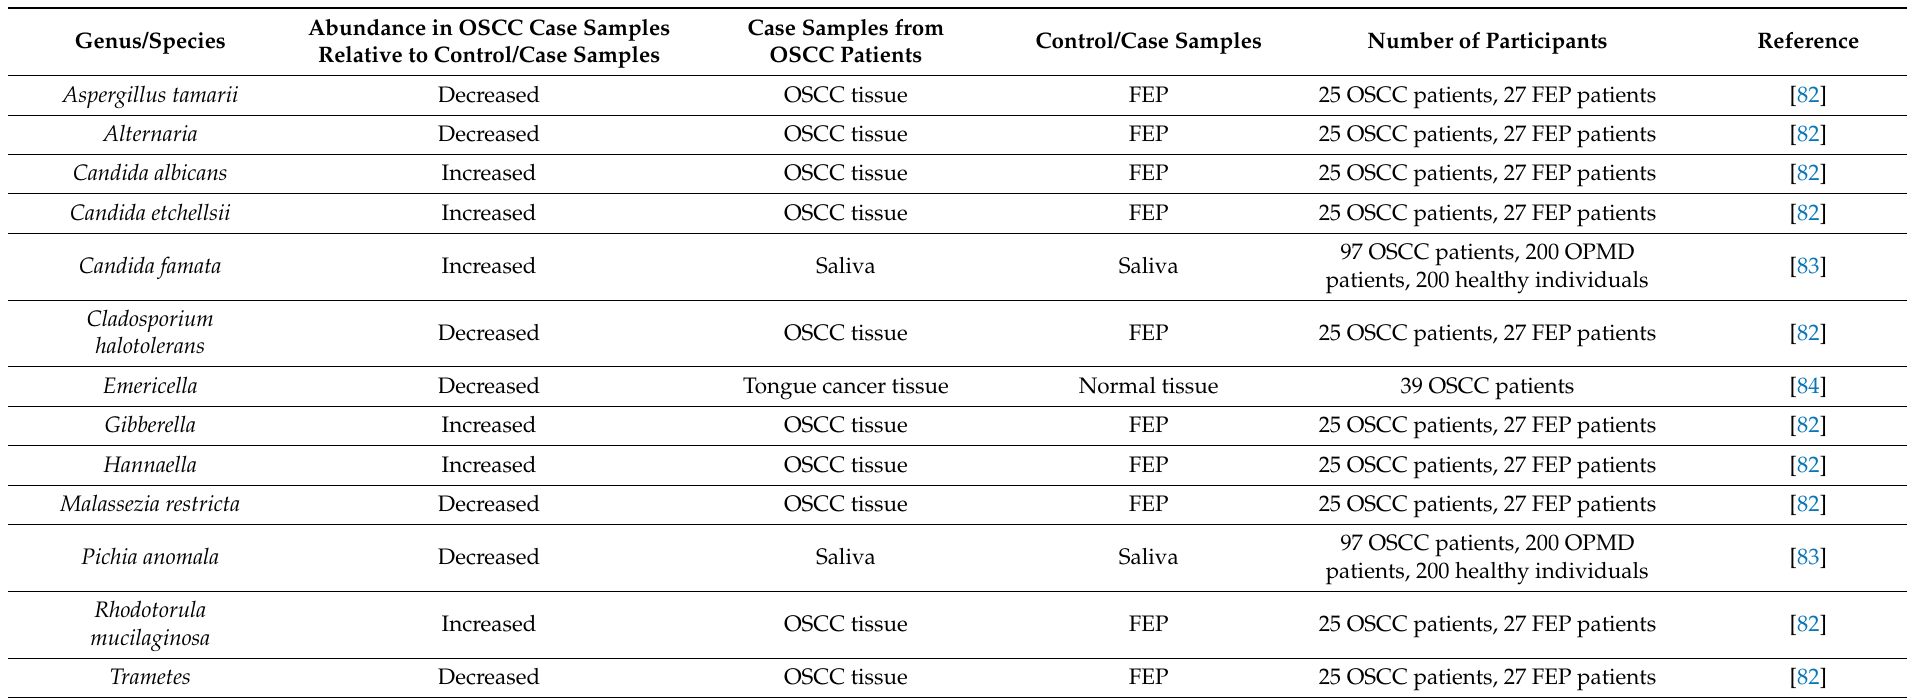
Table 2. Summary of mycobiota occurring in patients with oral cancer. Comparison of specific fungi abundance between case and control/case samples. All specimens were